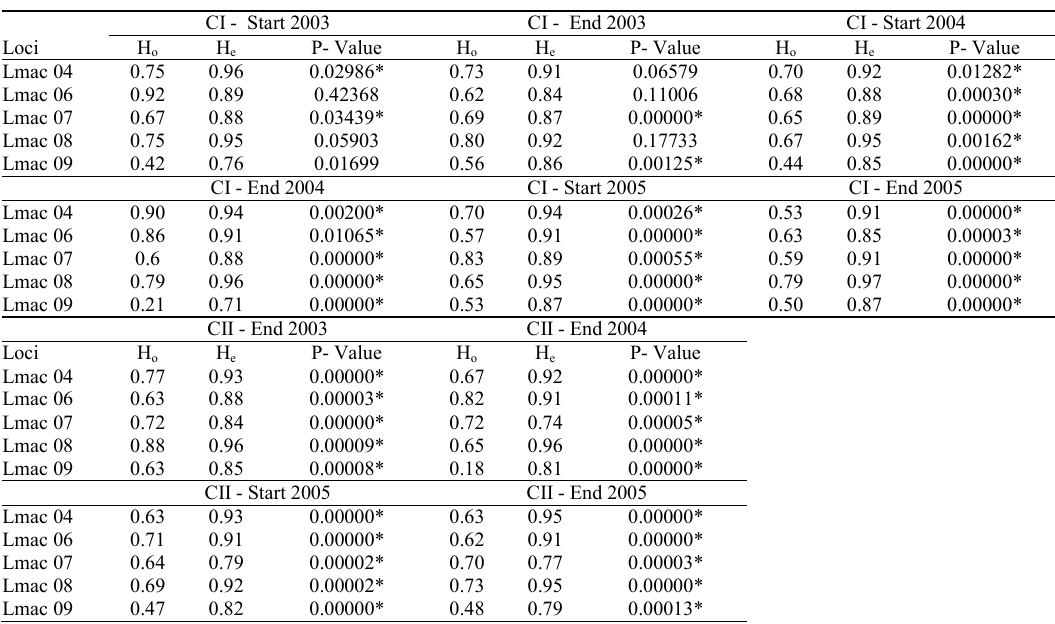
Table 6. Test of genetic equilibrium (H.W.E.) for the five microsatellite loci for the groups of Leporinus elongatus from the fish passage ladders of HEPs Canoas I and Canoas II- Paranapanema River. * Statistically significant value to 5%.